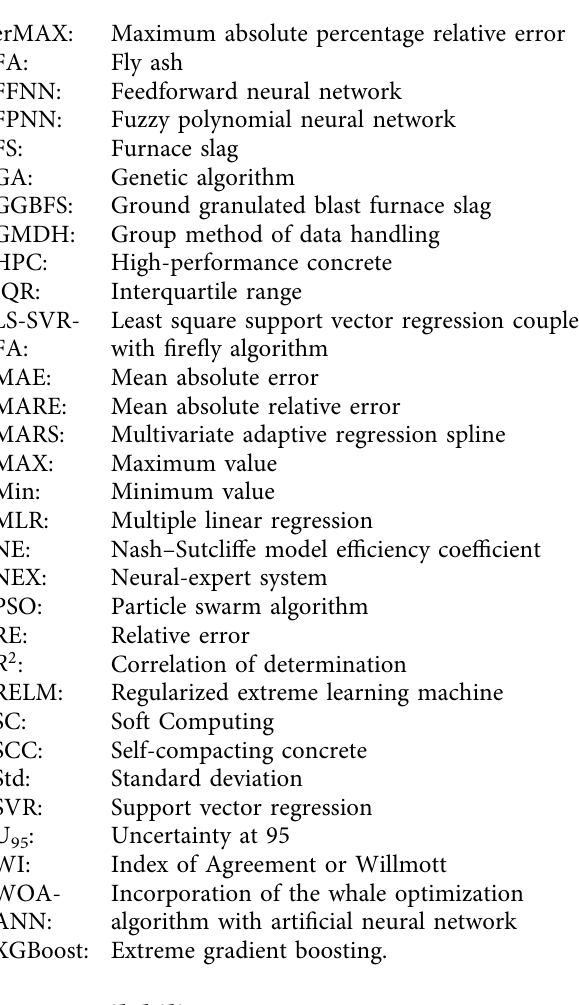
Incorporation of the whale optimization algorithm with artificial neural network XGBoost: Extreme gradient boosting. Data